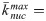
Time evolution of the pulling force per filament for different spontaneous nucleation rates, with representative ρ(r, y) plots.(A) Time courses of the pulling force per filament for k¯nucmax= 33%, 66% and 100% of the default value (Table 1). (B)-(D) Representative ρ(r, y) for each case; (D) represents the default model. The representative time point is chosen when the pulling force per filament reaches its maximum value while the invagination is greater than zero. The actin network in the middle is significantly sparser in (B) than in (D), causing the pulling force per filament to exceed the rupture force measured in Ref. [42].